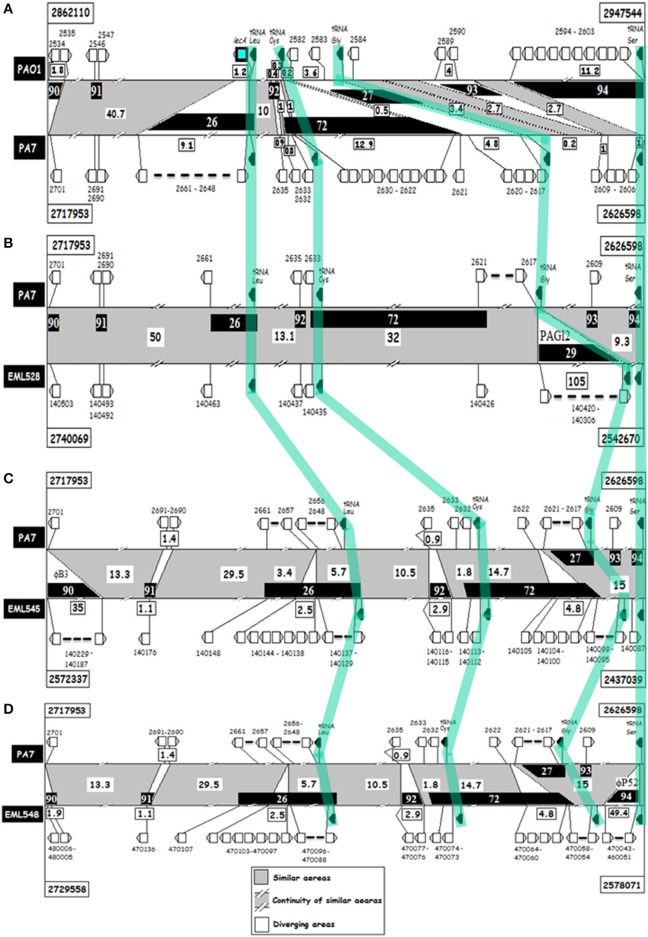
ACT analyses of lecA genomic regions of P. aeruginosa strains PAO1, PA7, EML528, EML545 and EML548. (A) PAO1 (top) against PA7 (bottom); (B–D), PA7 (top) against, respectively, EML528 (B), EML545 (C), and EML548 (D) regions (bottom). Horizontal black lines indicate the genome sequences compared over a length of about 80 kb. Gray indicates conserved regions, and white the variable ones. Distances between variable regions are given in kb. Regions of genomic plasticity (RGP) are indicated in black-boxes. Selected CDS (above or below the ACT panels), and tRNA genes (in black) are shown. Orthologous tRNA genes between pairs of genomes are highlighted by a light-green line crossing the ACT panels.